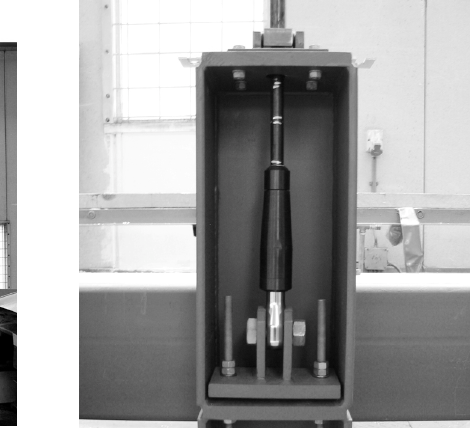
Figure 5: Overall view of the mock-up. Figure 6: Detail of the